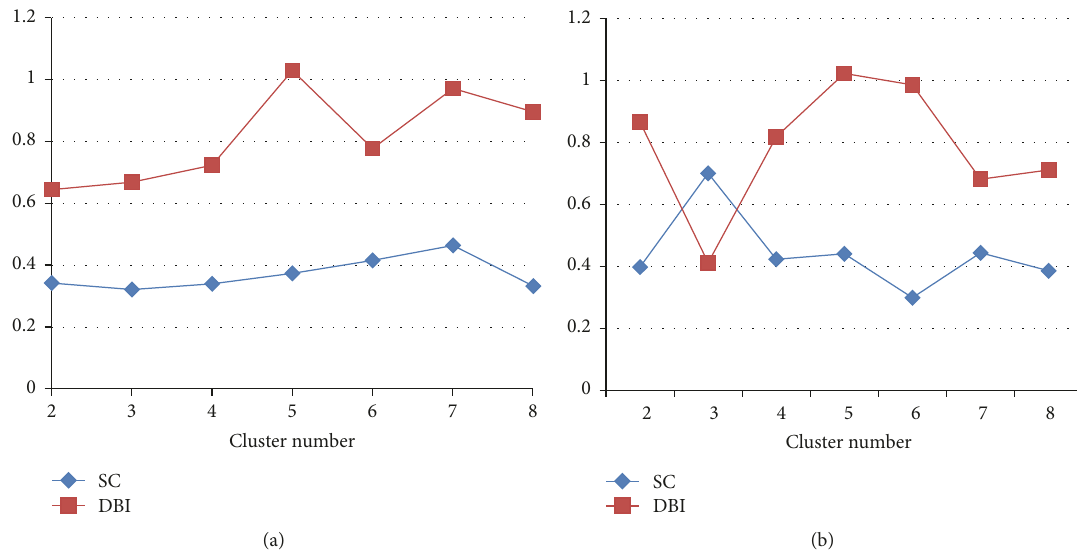
Figure 5: DBI and SC of weekdays and weekends. (a) Weekdays. (b)